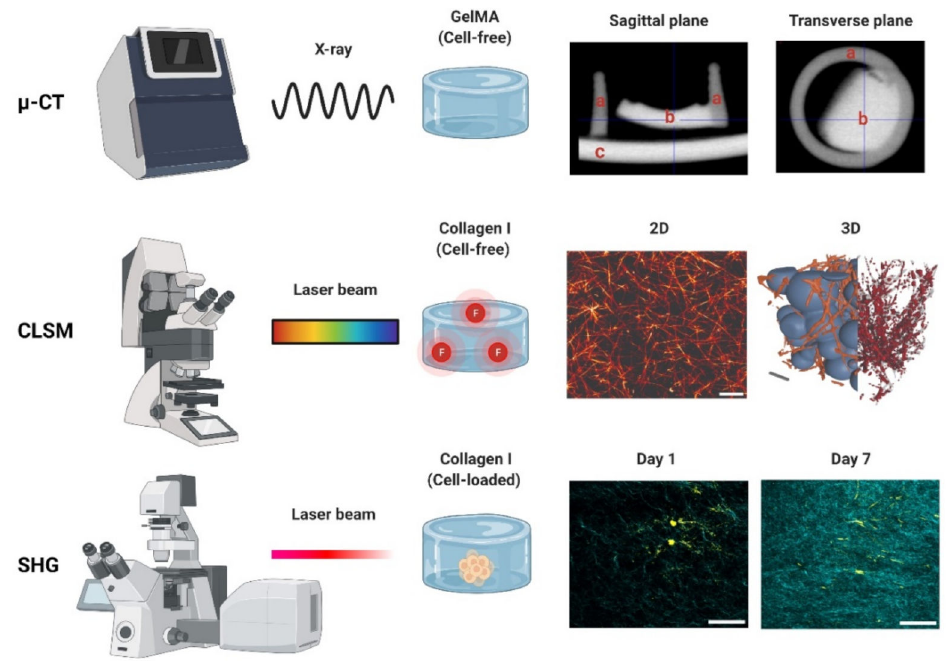
Figure 4. Photon-based imaging techniques. Micro-CT ( µ -CT) employs X-rays, creating contrast based on the material properties (e.g., thickness, composition). A GelMA hydrogel scanned with µ -CT is shown in both the sagittal and transverse planes: (a) indicates the PCL container used for casting (2 mm diameter), (b) the GelMA hydrogel, and (c) the stage holder. Confocal laser scanning microscopy (CLSM) employs a laser to excite a fluorophore, which emits the fluorescent signal used for detection. Images of a collagen type-I hydrogel (3 g/L) are shown in 2D and 3D. The 3D image can be used to determine the interconnectivity of the polymer network (orange/red) using a bubble analysis (blue). Scale bars represent 5 µ m (2D) and 10 µ m (3D). Second harmonic generation (SHG). An example of a cell-loaded (fibroblast) collagen type-I hydrogel is shown on day 1 and day 7. The increase in the SHG signal indicates an increase in the collagen deposition during cell culture. SHG data derived from paraffin-embedded formalin-fixed hydrogels. Scale bars represent 50 µ m. µ -CT, CLSM and SHG used to generate the data detailed in Appendix